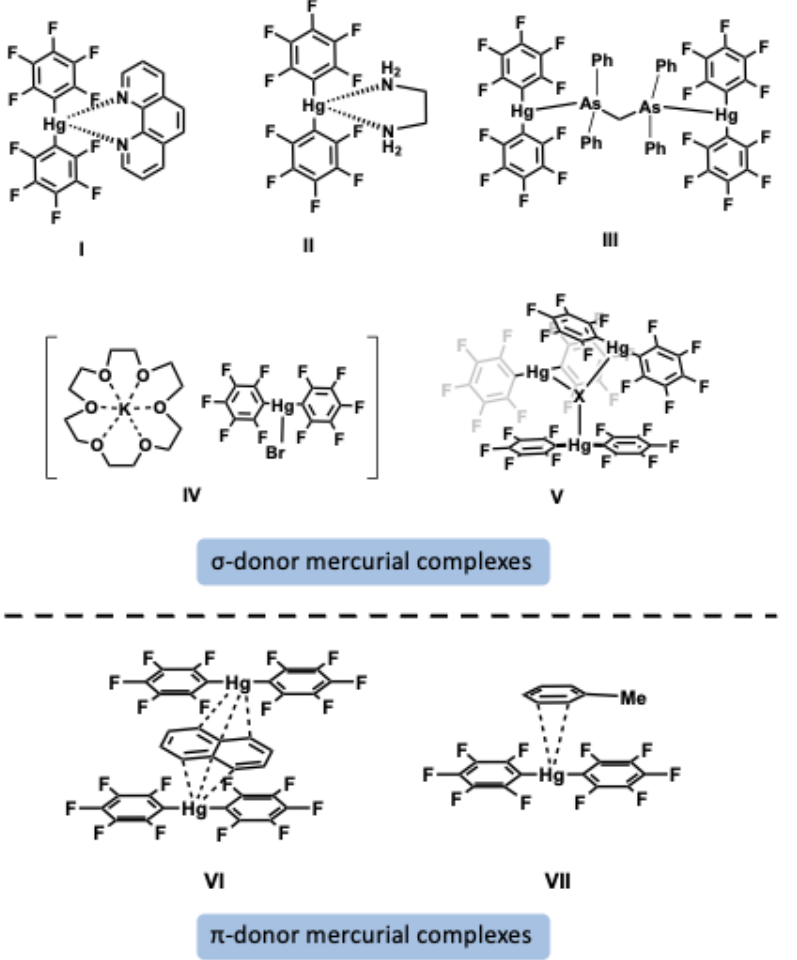
Chart 1. Selected complexes of bis(pentafluorophenyl)mercury(II) with σ - and π -donor moieties